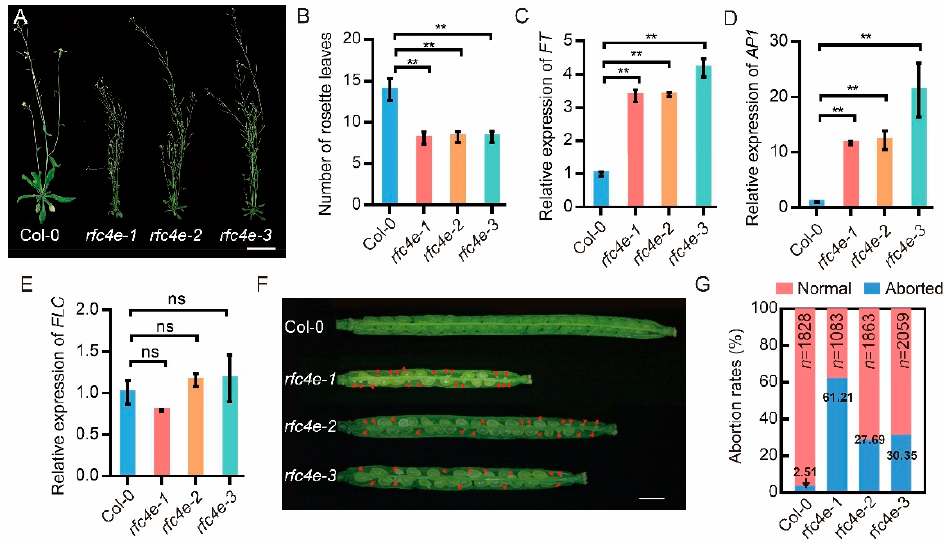
Figure 2. AtRFC4 mutation causes earlier flowering and seed abortion. ( A ) Morphological phenotype of Col − 0, rfc4e − 1, rfc4e − 2 and rfc4e − 3 at 50 days after germination. Bar = 2 cm. ( B ) The number of rosette leaves when plant blooms, n > 50. ( C − E ) Relative expression of FT ( C ), AP1 ( D ) and FLC ( E ) in rfc4e − 1 , rfc4e − 2, rfc4e − 3 and Col − 0. Total RNA extracted from 12 − d − old seedlings was reverse-transcribed. The expression in Col − 0 was used as a standard for normalization control. Data are means of triplicate technical repetitions from one of three biologically independent experiments. Error bars indicate ± SD. ( F ) Ovule phenotypes in siliques of Col − 0, rfc4e − 1 , rfc4e − 2 and rfc4e − 3 . More than 30 siliques were counted, and the aborted ovules are labeled by red arrows. Bar = 1 cm. ( G ) Seed abortion ratios of Col − 0, rfc4e − 1, rfc4e − 2 and rfc4e − 3 plants. The total number of seeds counted is listed at the top of the histogram bars and the seed abortion ratio at the bottom. Pale seeds repre- sented delayed embryos and/or aborted seeds. Error bars indicate ± SD, n > 1000 (** p < 0.01), ns, no significance.